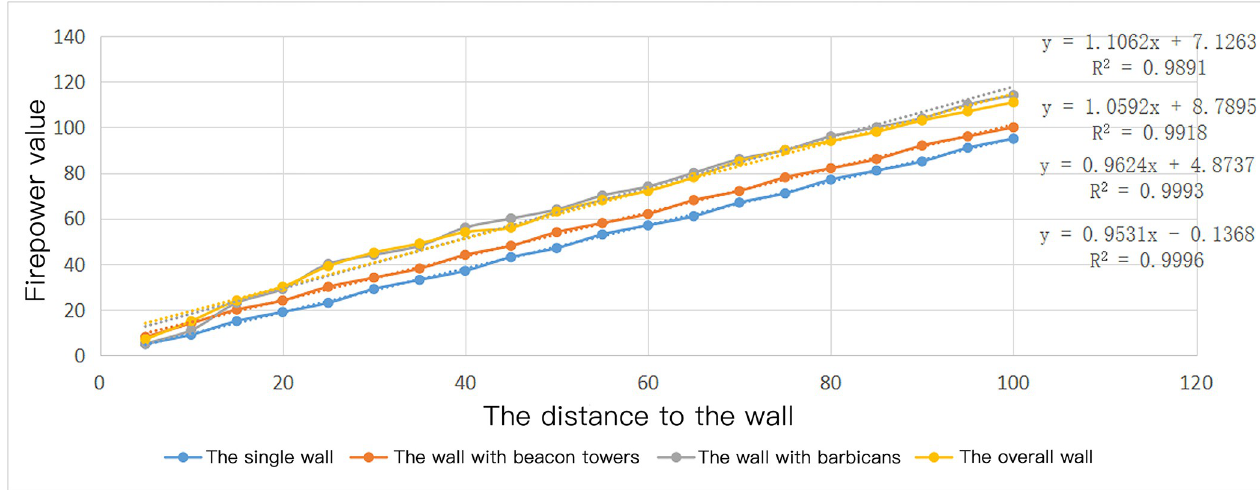
Fig 11. Measurement graph of walls on firepower